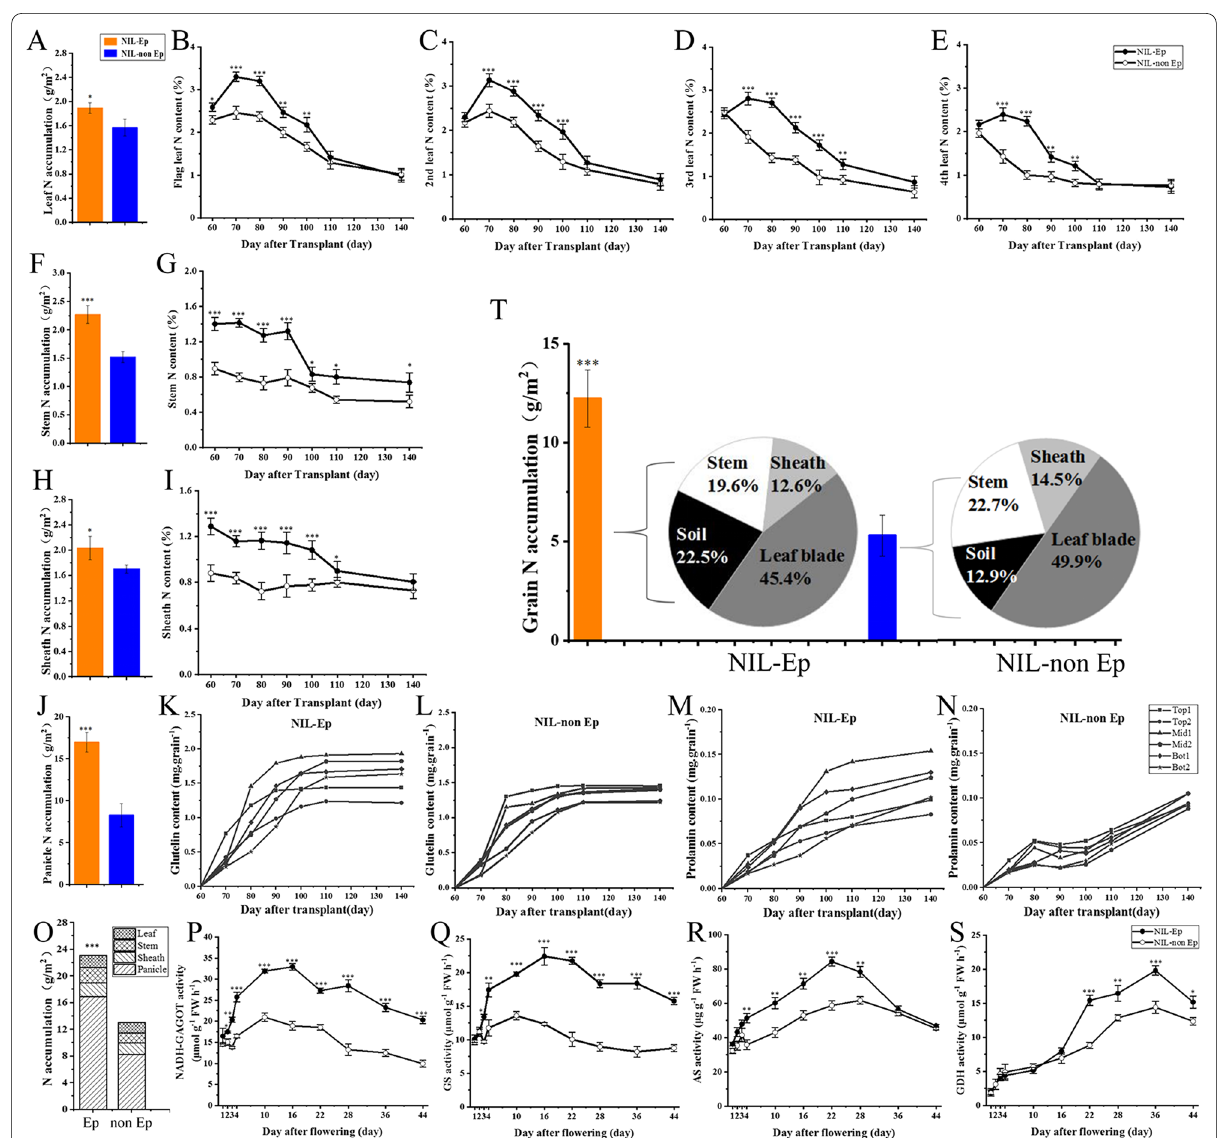
Fig. 4 Differences in nitrogen transfer and nitrogen metabolism-related enzyme activities of NIL-Ep and NIL-non Ep plants under high nitrogen treatment. A Leaf nitrogen accumulation at maturity stage. B – E Dynamics of leaf (from flag leaf to 4th leaf) nitrogen content. F Stem nitrogen accumulation at maturity stage. G Dynamics of stem nitrogen content. H Sheath nitrogen accumulation at maturity stage. I Dynamics of leaf sheath nitrogen content. J Grain nitrogen accumulation at maturity stage. K – N Dynamics of glutelin and prolamint content in different panicle positions. O Total nitrogen accumulation at maturity stage. P – S Activities of enzymes related to nitrogen metabolism. GS: glutamine synthetase, GOGAT: glutamate synthase, AS: asparagine synthetase, GDH: glutamate dehydrogenase. T Origin of nitrogen in panicles from various organs and soils in rice from heading to mature period. The N represent nitrogen element. The *, ** and *** Significance at 0.05, 0.01, and 0.001 level